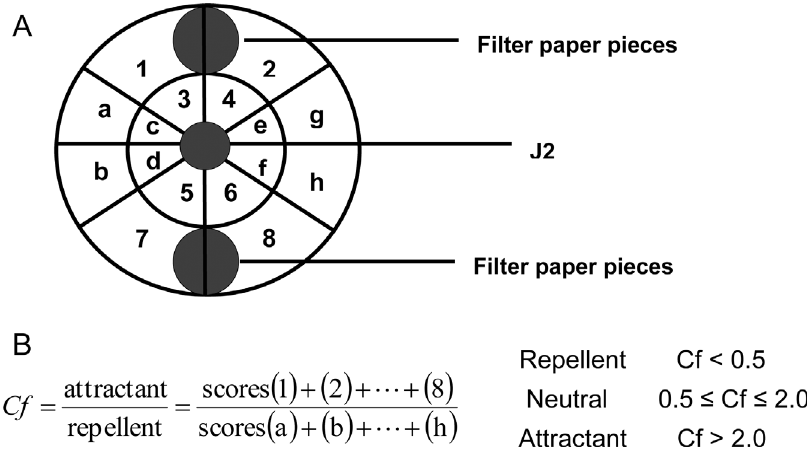
Fig 1. Diagram of in vitro chemotaxis assay. (A) Grid for the analysis of nematode preferential orientation on the medium; each segment of the grid was given a score for the presence (1) or absence of nematode tracks (0); (B) Calculation of the chemotaxis factor